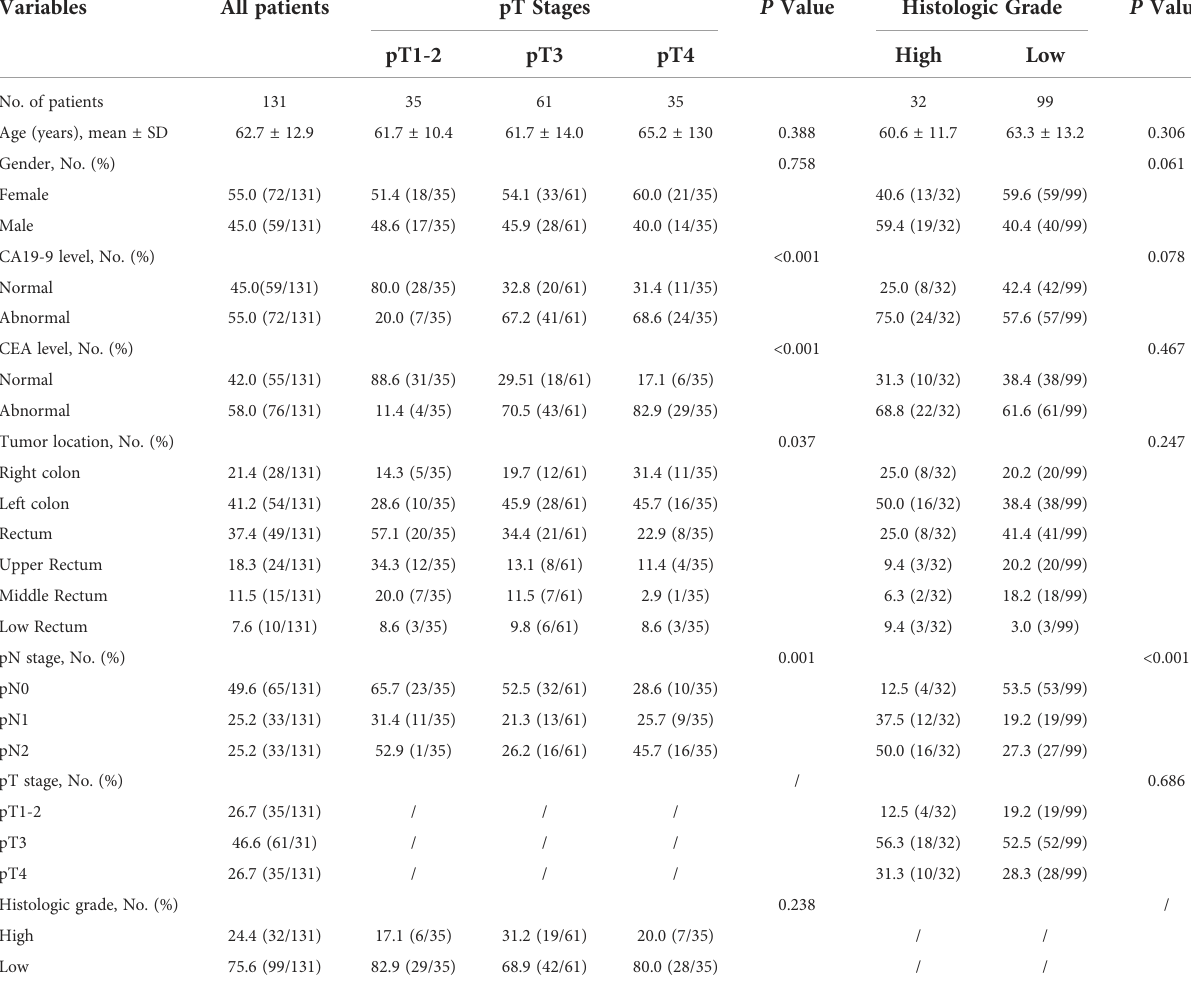
TABLE 1 Clinical pathological characteristics on 131